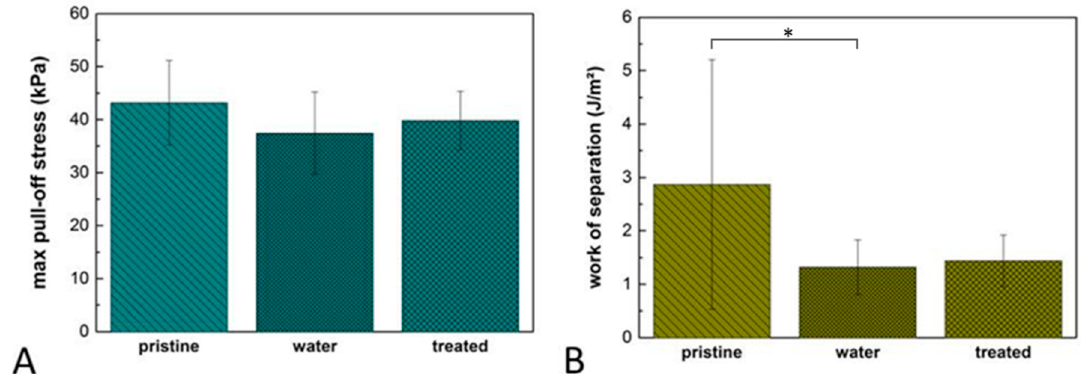
Figure 5. Normal tack analysis of composite films. The films consist of a Sylgard 184 backing layer with a thickness of 43 ± 11 µm and SSA layer exhibiting a thickness of 157 ± 22 µm. Max pull-off stress ( A ) and work of separation ( B ) were determined using a rough glass substrate. Number of independent experiments n = 3. Original data is included in Supplementary Table S2. * indicates p ≤ 0.05.